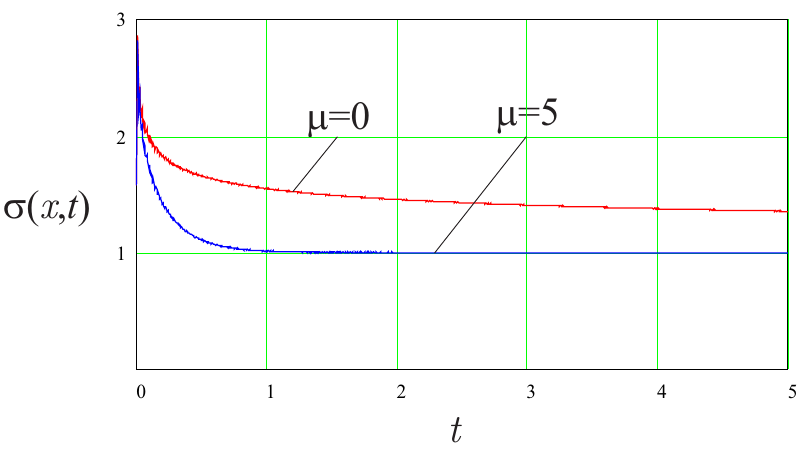
Figure 1. Stress relaxation curves for a = 0.2, b = 1, α =